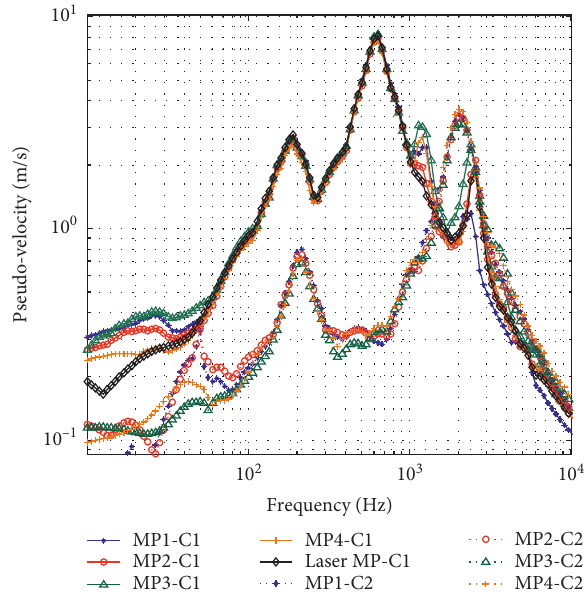
Figure 15: Pseudovelocity shock response spectrums on C1 and